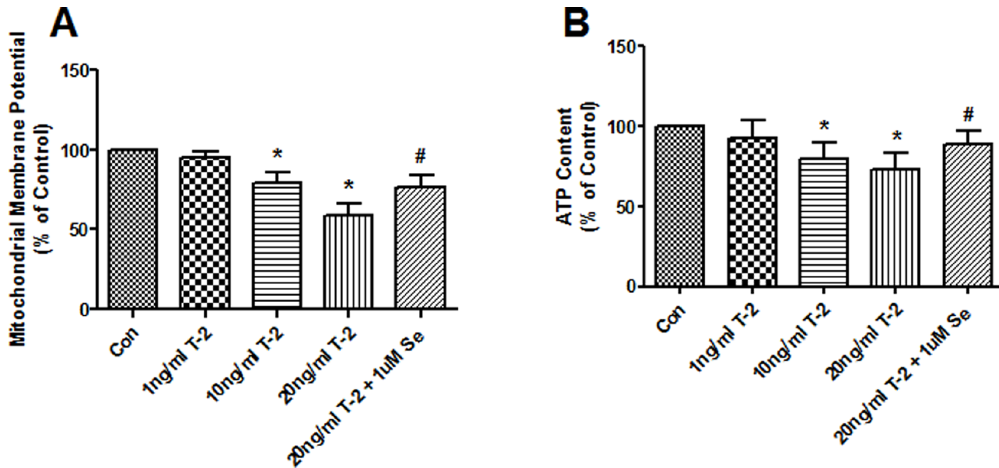
Figure 2. Effects of T-2 toxin on the mitochondrial membrane potential and ATP. A. Normal human chondrocytes were exposed to 1 10, 20 ng/ml T-2 toxin and 1 uM Na 2 SeO 3 + 20 ng/ml T-2 toxin for 5 d. The mitochondrial membrane potential of chondrocytes was analyzed using the fluorescent dye JC-1, and quantified by a flow cytometer. B. Effect of different concentrations of T-2 toxin on the cellular ATP. * P , 0.01 vs. control; # P , 0.01 vs. 20 ng/ml T-2 toxin group.